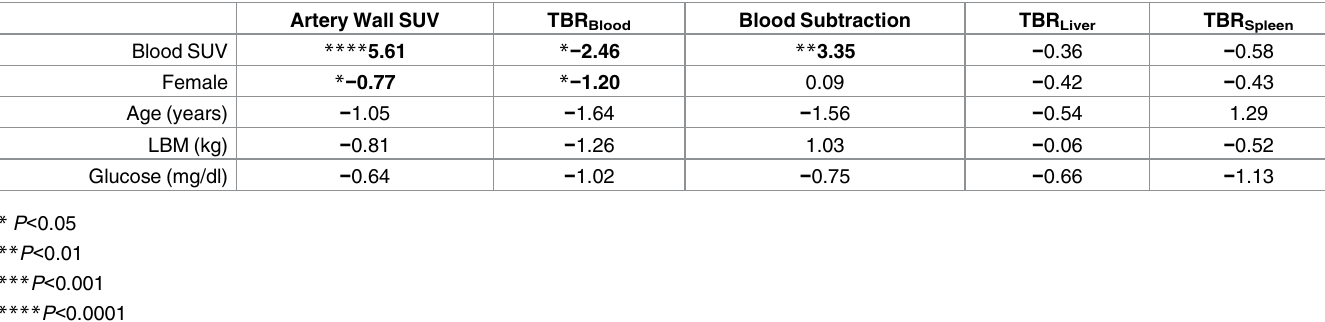
Table 3. Multivariate regression models of confounding variables associated with measurement methods of arterial activity. Columnheadersare dependentvariables and rows are